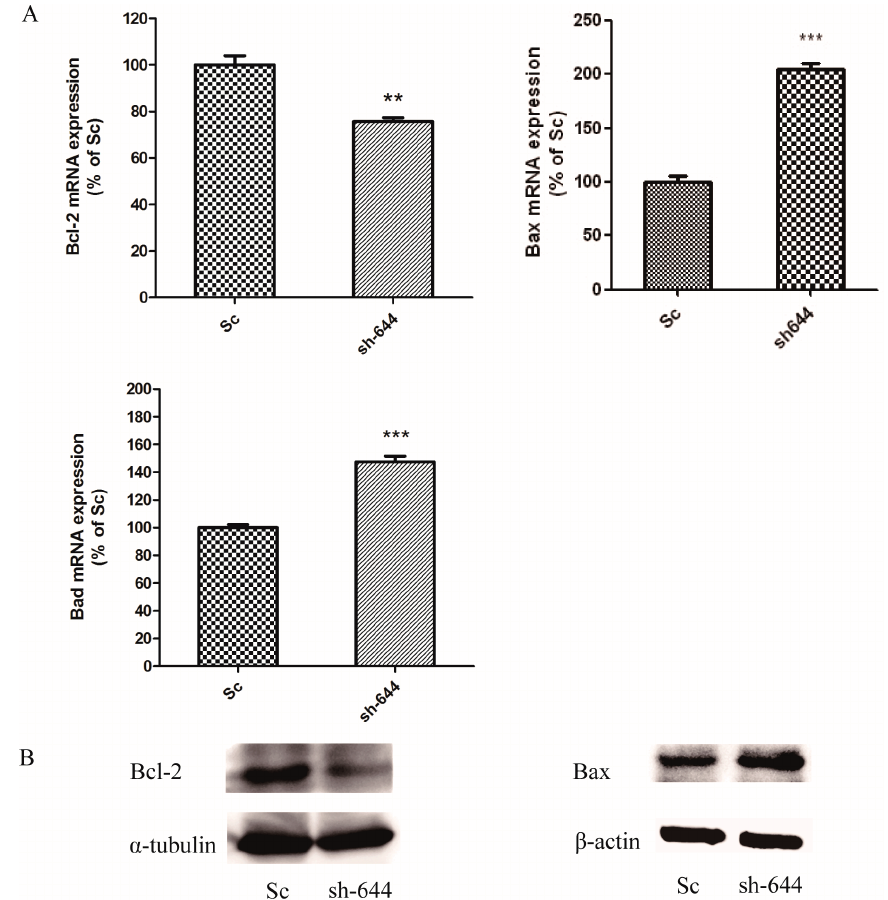
Figure 3. Altered expression levels of apoptosis-related genes Bax , Bcl-2 and Bad in the Clu -knockdown N2a cells. ( A ) Real-time PCR detection of Bax , Bcl-2 and Bad mRNA expression; ( B ) Western blot analyses of Bax and Bcl-2 protein expression. Cells transfected with pGPU– Clu –mus–shSc (Sc) were used as the control. ** p < 0.01 and *** p < 0.001 vs. the